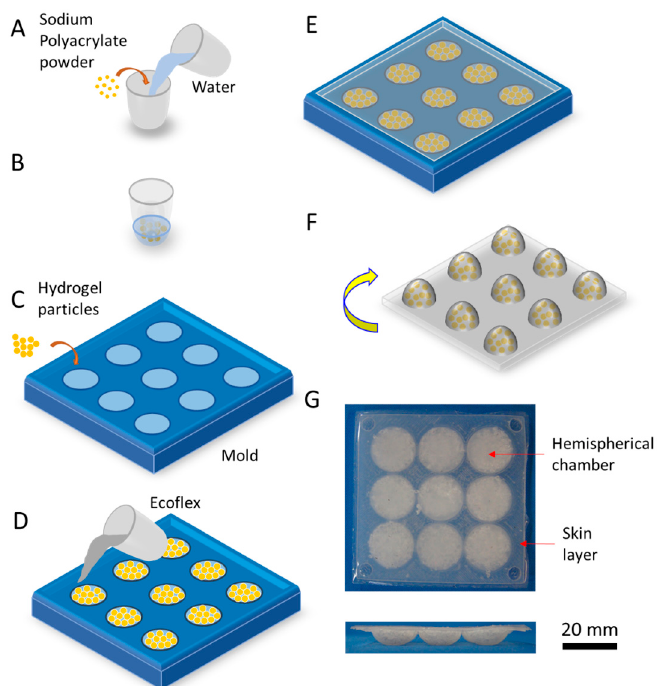
Figure 2. Fabrication of a soft layer using hydrogel-elastomer composites. ( A ) Combine powdered sodium polyacrylate with water; ( B ) wait 2 min for gel to form; ( C ) fill hemispherical chambers of the printed mold with hydrated hydrogel particles; ( D ) pour the prepared Ecoflex into the mold; ( E ) wait 30 min for Ecoflex to cure in an oven at 60 °C; ( F ) remove the soft composite material from the mold; ( G ) photograph of the soft layer in top view and side view.